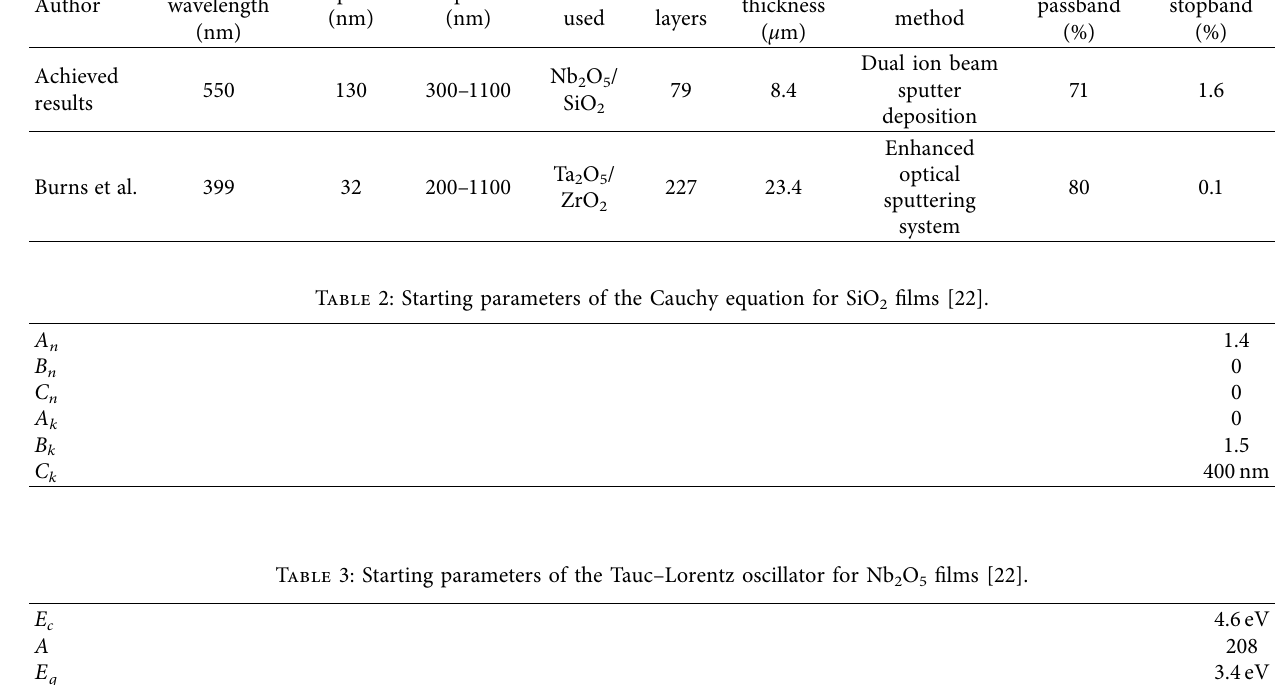
Table 1: Comparison of diferent parameters of a state-of-the-art optical flter with this work.